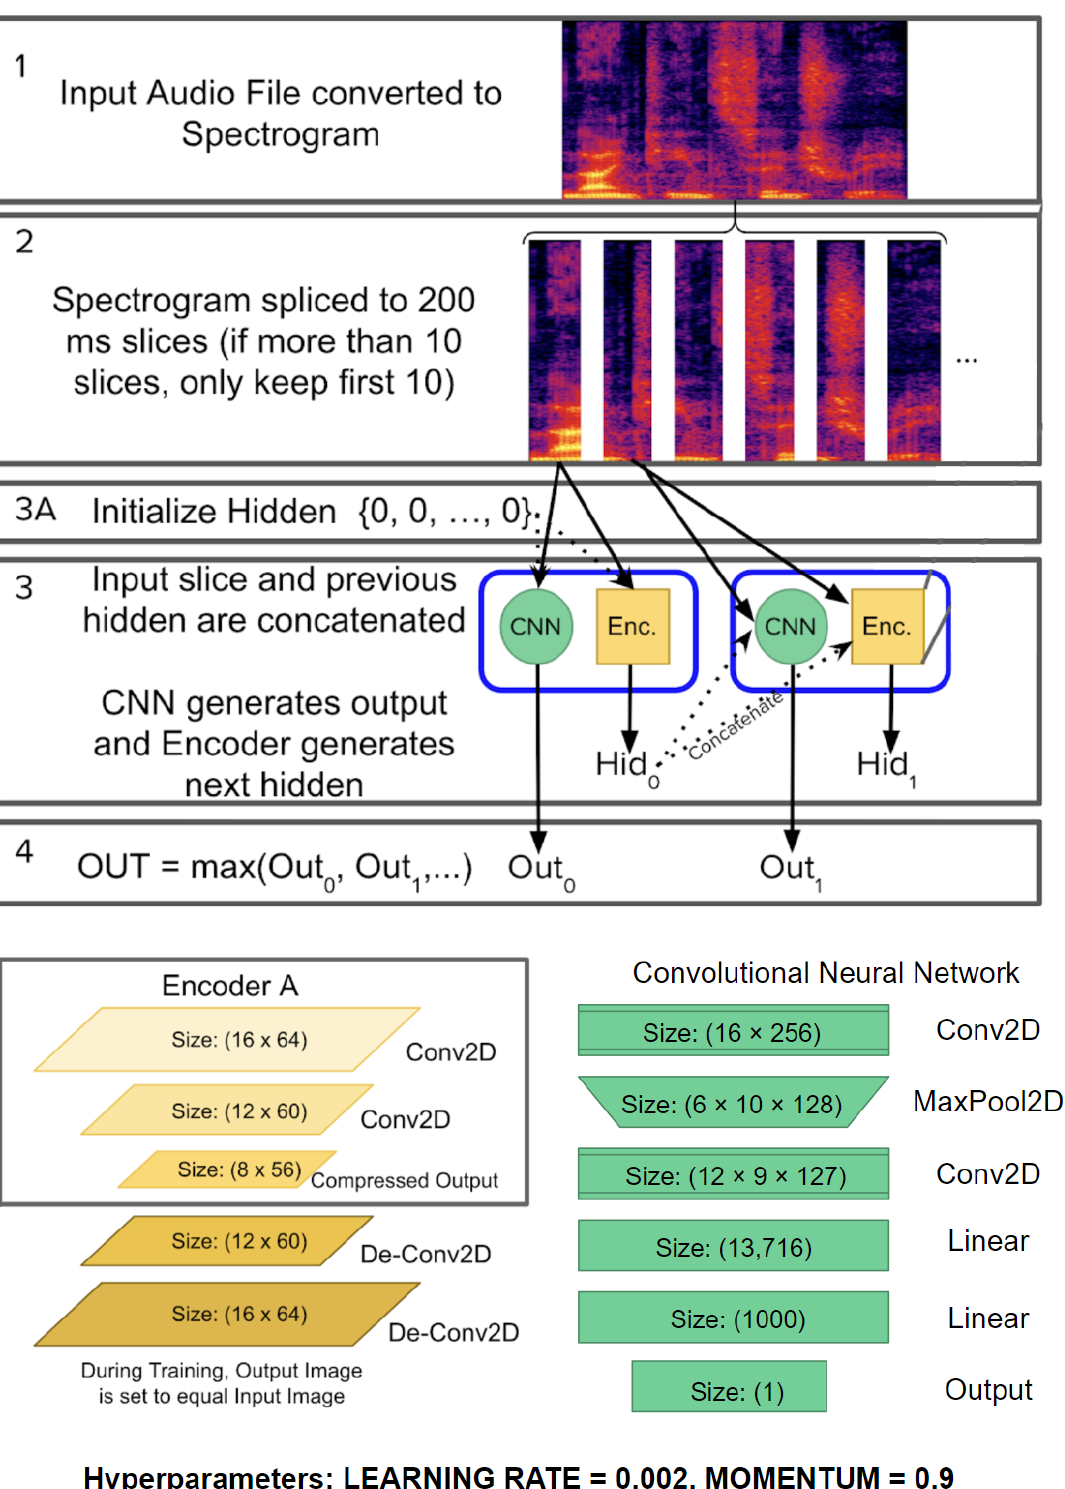
Figure 2. Architecture for the new machine learning model, which is referred to as the spatio- temporal artificial intelligence network (STAIN). This proposed AI model deeply blends the elements of both convolutional and recurrent neural networks, and effectively learns both spatial and temporal features encoded within the respiratory sound spectrograms for accurate